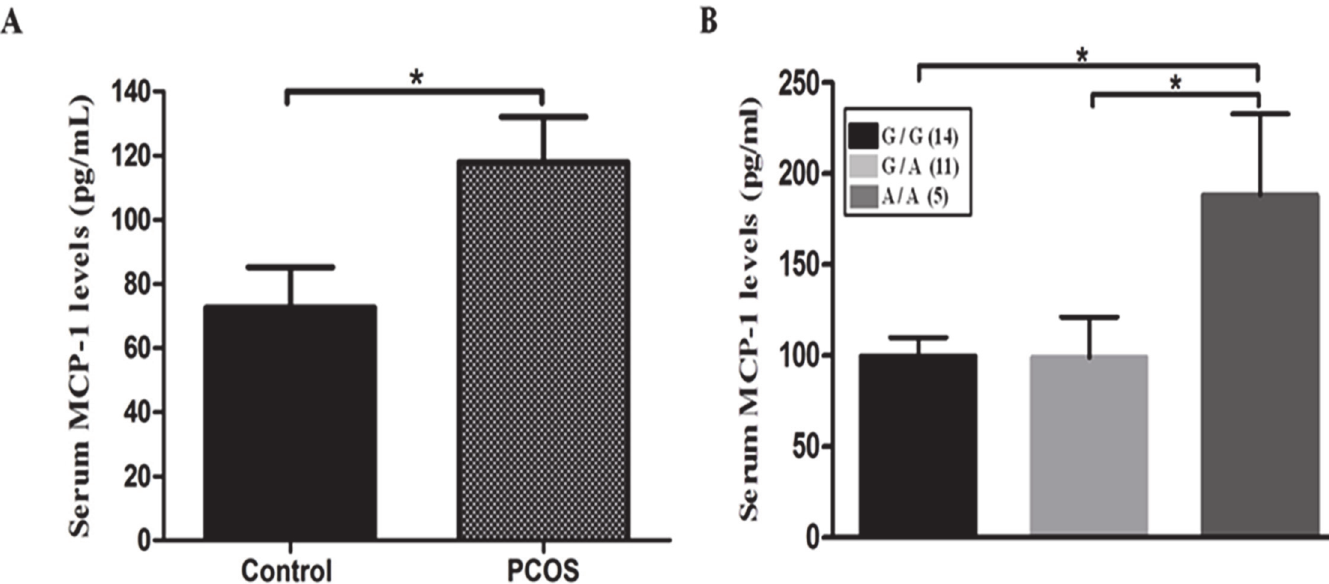
Fig 3. MCP-1 levels in the serum of controls (n = 25) and PCOS patients (n = 30) were quantified by ELISA (mean ± SEM of duplicate wells). A, 72.64 ± 12.58 pg/ml in controls; 118.0 ± 14.11 pg/ml in PCOS patients. * P < 0.05. Data were analyzed by unpaired t -test. B, Serum MCP-1 levels in women with PCOS according to the genotypes of SNP -2518G > A. Data are presented as means ± SEM.